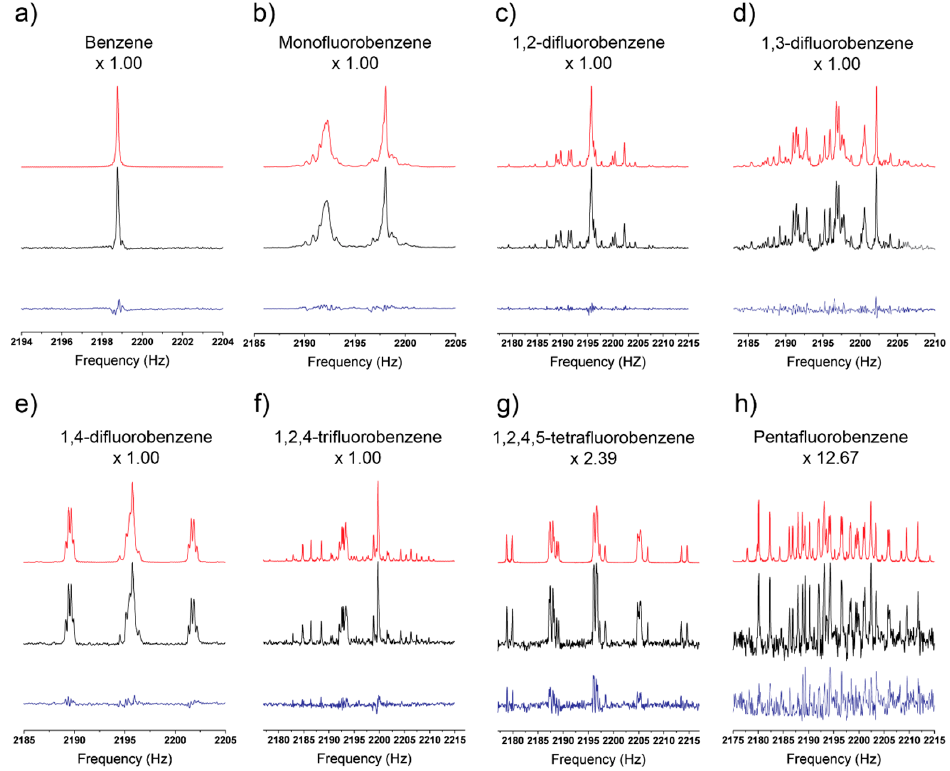
Figure 3. The 1 H region of the JCS for benzene ( a ), monofluorobenzene ( b ), 1,2-difluorobenzene ( c ), 1,3-difluorobenzene ( d ), 1,4-difluorobenzene ( e ), 1,2,4-trifluorobenzene ( f ), 1,2,4,5-tetrafluorobenzene ( g ), and pentafluorobenzene ( h ). The black lines are the experimentally measured spectra, the red lines are the simulated spectra, and the blue lines are the residuals between the experimental and simulated spectra. Each spectrum also has a scaling factor, which is denoted below the compound name, indicating the amount the experimental, simulated, and residuals that were multiplied such that the maximum peak intensities of the experimental spectra (a-h) were equivalent.